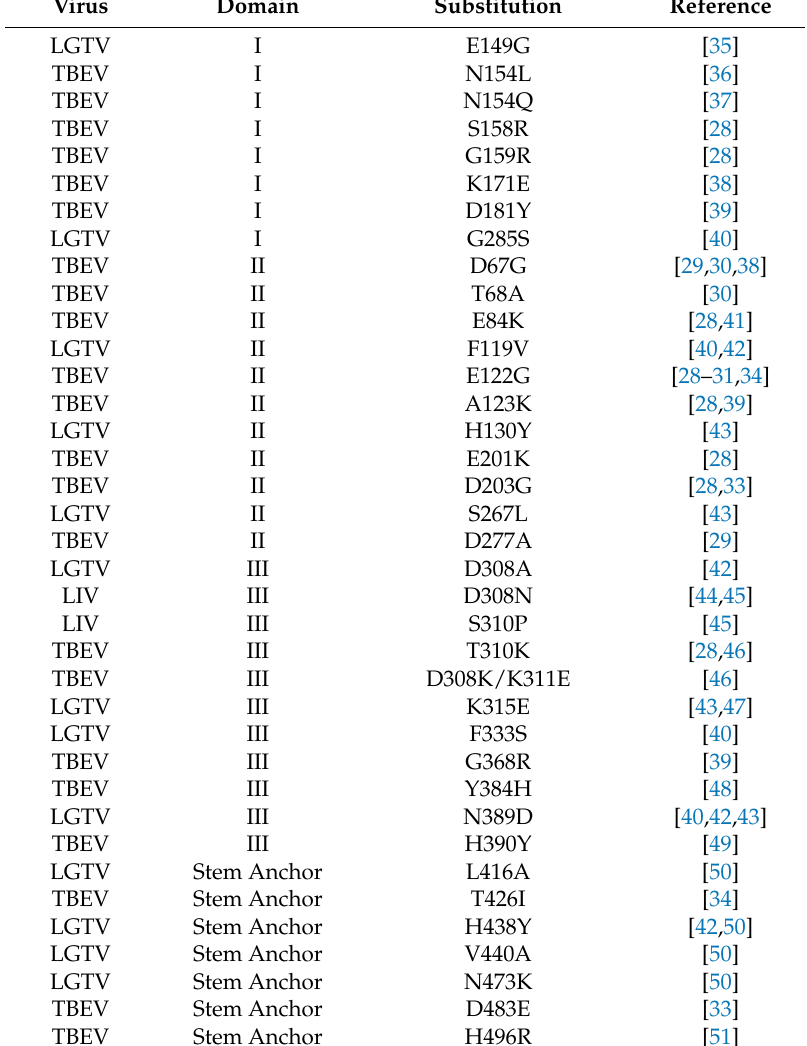
Figure 1. Residues implicated in virulence in the E protein. The homodimer of TBEV protein E is shown. Domain I is shown in red, domain II in yellow, domain III in blue, FG loop of domain III is noted in green. Residues implicated in virulence (summarized in Table 1) are indicated in grey. Stem anchor not shown (Residues 401–496). Table 1. Mutations affecting neuroinvasiveness and neurovirulence in the E protein.